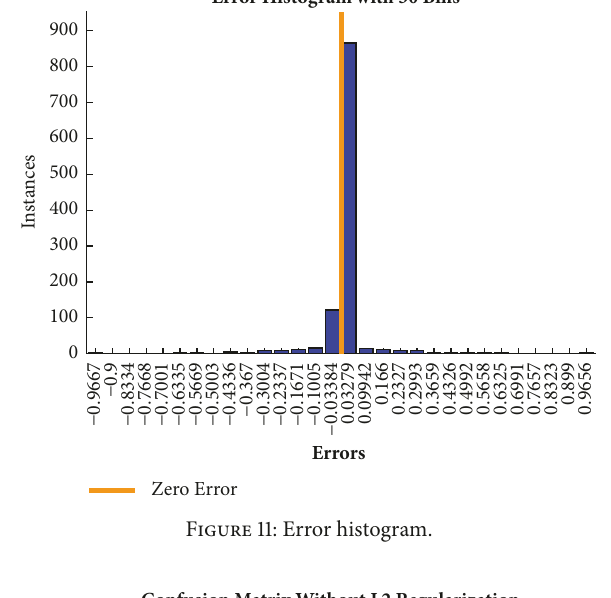
Figure 11: Error histogram.